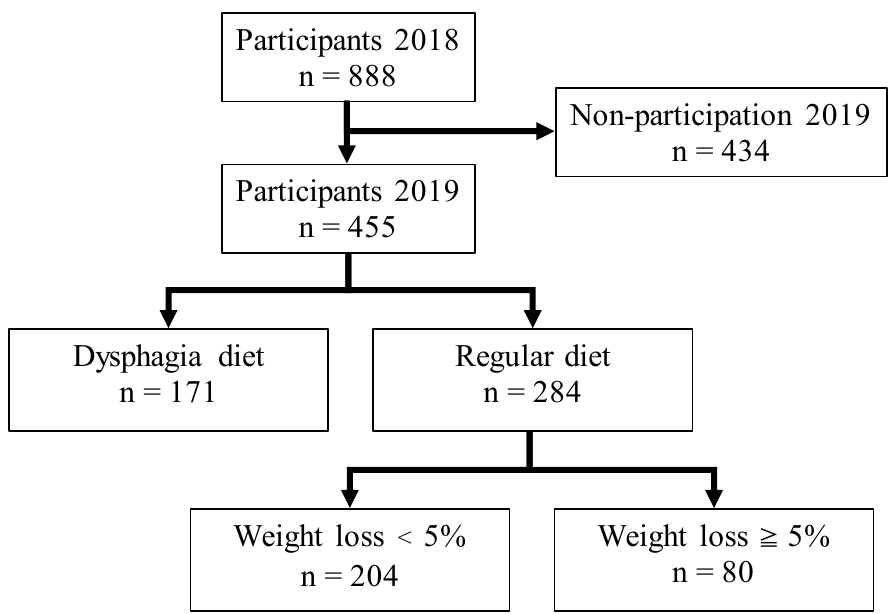
Figure 1. Flowchart of study participants.